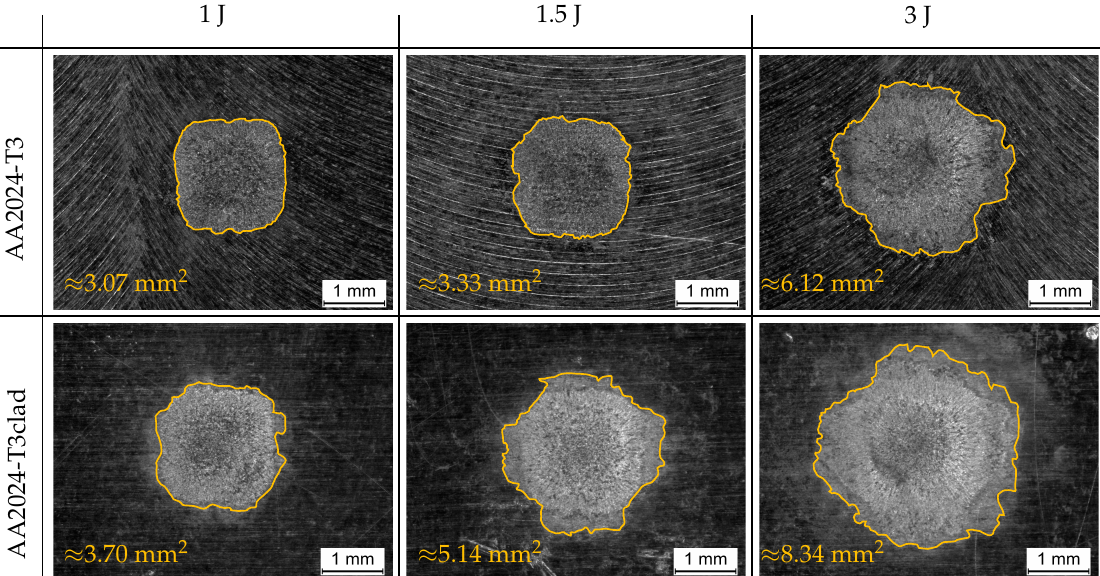
Figure 9. Light optical micrographs for AA2024-T3clad and AA2024-T3 for single LP shots with a 1 mm × 1 mm squared laser focus with three laser energies: 1 J, 1.5 J, and 3 J. The size of the affected area on the specimens’ surface is indicated.